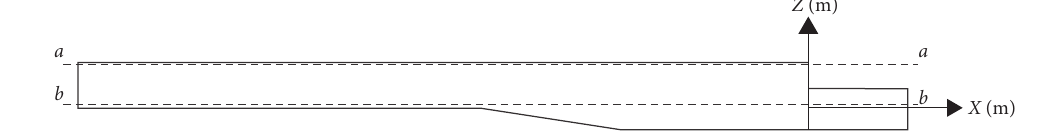
Figure 4: Schematic of the position of each section. Table 4: Comparison of diversion pier parameter settings.